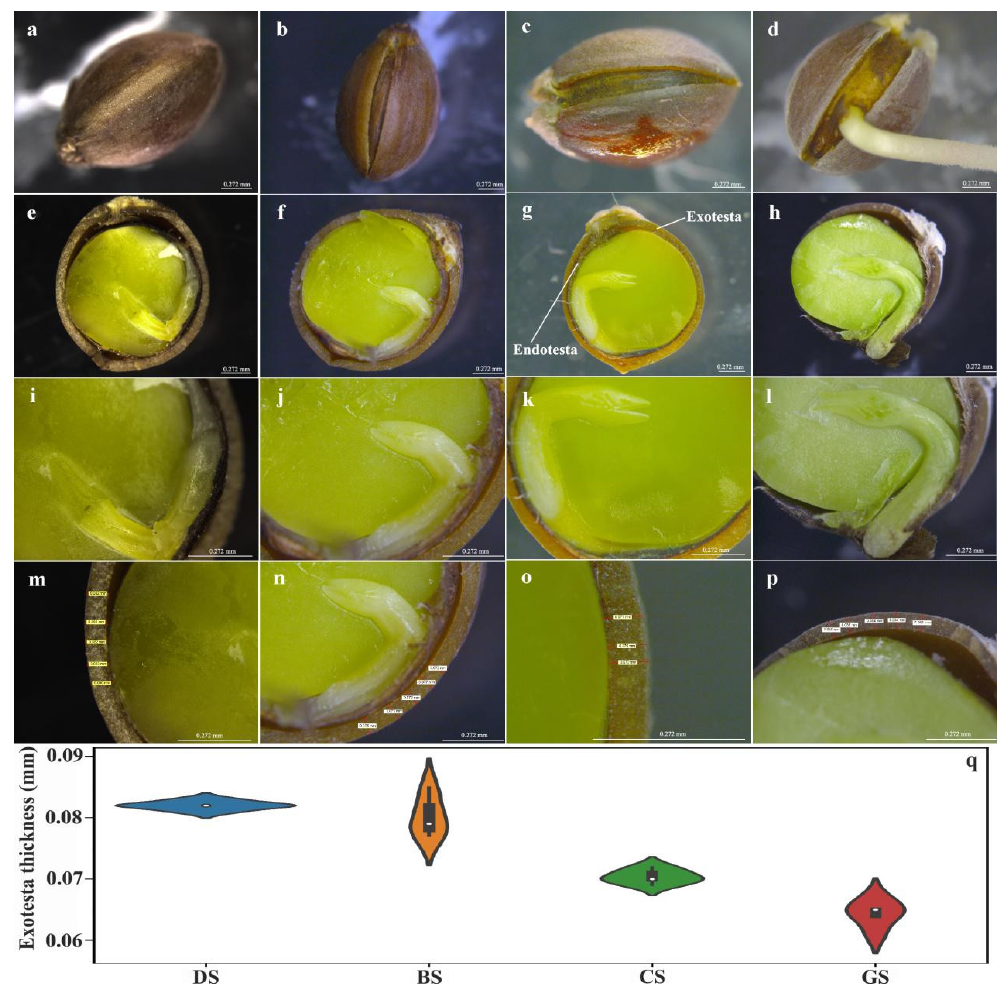
Figure 3. Morphology of Chinese pistache seeds during germination under a stereomicroscope. Raphe of intact dry (DS), imbibed (BS), cracked (CS), and germinated (GS) seeds ( a – d ); longitudinal section of DS, BS, CS, and GS ( e – h ); embryos of DS, BS, CS, and GS ( i – l ); exotesta section of DS, BS, CS, and GS ( m – p ); and exotesta thickness of DS, BS, CS, and GS ( q ).